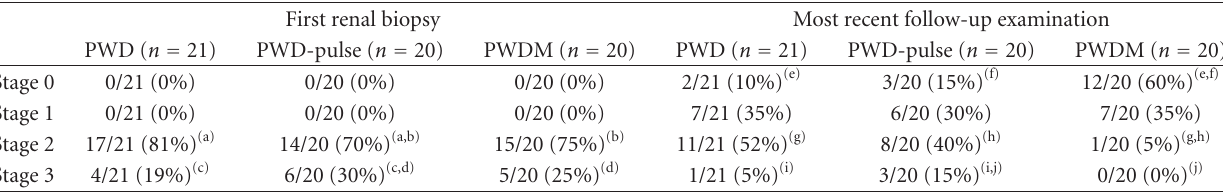
Table 4: Comparison between clinical stages in the three groups at the time of the first renal biopsy and the most recent follow-up